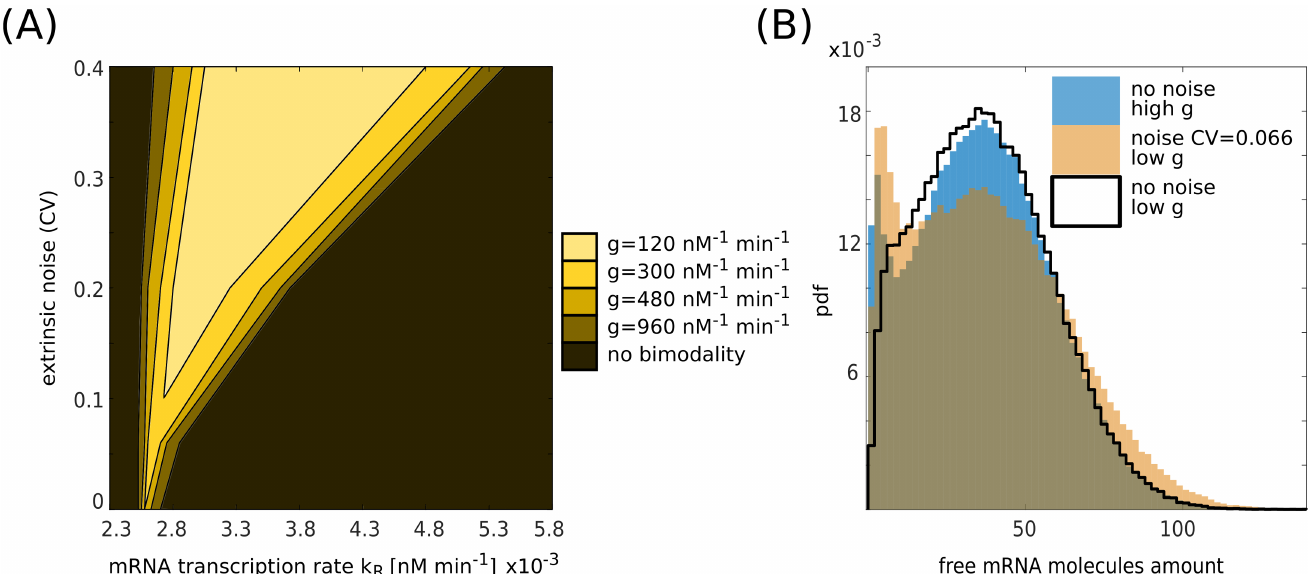
Fig 4. Bimodality as a function of the parameters. (A) Phase diagram for bimodality in the free mRNA molecules distribution. On the x axis there is the target transcription rate k R , on the y axis the extrinsic noise on the miRNA transcription rate. The color map indicates the presence of bimodality for different values of the miRNA-target interaction strength g . The presence of bimodality was computed by running several Gillespie’s simulations for fixed sets of parameters and sampling targets’ probability distributions. By using Matlab interpolation functions, we extracted the number of maxima of the distributions and used this value as a first measurement of bimodality. In the SI, we discussed a more refined version of this measurement. The width of the bimodality range increases as the interaction strength or the extrinsic noise are increased. The following parameters are equal for all the simulations: g = 1.2 × 10 −2 min −1 , g = 2.4 × 10 −2 min −1 , k = 6.0 min −1 , S R P g P = 1.2 × 10 −2 min −1 , α = 0.5. Target mRNA transcription rate is one of the control parameters and ranges from k R = 2.3 × 10 −3 nM min −1 to k R = 5.8 × 10 −3 nM min −1 . miRNA-mRNA association rate is one of the control parameters and takes the following values: g = 1.2 × 10 2 nM −1 min −1 , 3.0 × 10 2 nM −1 min −1 , 4.8 × 10 2 nM −1 min −1 , 9.6 × 10 2 nM −1 min −1 . Extrinsic noise is tuned by varying the standard deviation of the distribution with mean (cid:22) k ¼ 1 : 2 (cid:2) 10 (cid:0) 3 nM min (cid:0) 1 from which S miRNA transcription rates are picked, the standard deviation takes the following values: σ = 0 nM min −1 (no extrinsic noise), 7.1 × 10 −5 nM min −1 , 2.4 × 10 −4 nM min −1 , 4.8 × 10 −4 nM min −1 . To define the origin of the bimodality region for the case with g = 1.2 × 10 2 nM −1 min −1 the value σ = 1.2 × 10 −4 nM min −1 was also used. In the SI, a more systematic non-binary study of the appearance of the bimodality is reported (see S5 Fig). (B) Free mRNA distribution in case of pure intrinsic noise and small ( g = 3.8 × 10 2 nM −1 min −1 ) miRNA-target interaction strength (black line), pure intrinsic noise and high ( g = 1.1 × 10 3 nM −1 min −1 ) miRNA-target interaction (blue histogram) and extrinsic noise ( σ = 7.9 × 10 −5 nM min −1 ) and small ( g 1 = 3.8 × 10 2 nM −1 min −1 ) miRNA-target interaction strength (orange histogram). The other parameters are as follows: k = 1.2 × 10 −3 nM min −1 , g = 1.2 × 10 −2 min −1 , k = 2.7 × 10 −3 nM min −1 , g = 2.4 × 10 −2 min −1 , k = 6.0 min −1 , g = S S R R P P 1.2 × 10 −2 min −1 , α = 0.5. The plot shows how extrinsic noise can compensate for small miRNA-target interaction strength in order to obtain bimodal distributions.